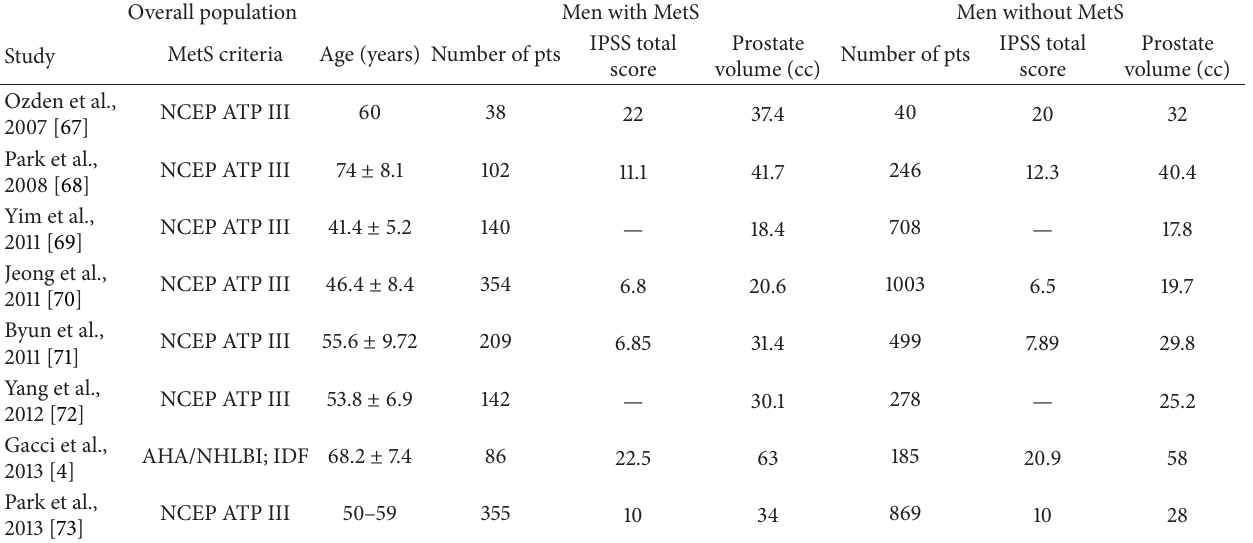
Table 1: Characteristics of the studies comparing International Prostatic Symptom score (IPSS) and prostate volume in patients with and without metabolic syndrome (MetS) according to different criteria. NCEP-ATPIII: National Cholesterol Education Program-Third Adult Treatment Panel; IDF: International Diabetes Federation; AHA/NHLBI: American Heart Association/National Heart, Lung, and Blood